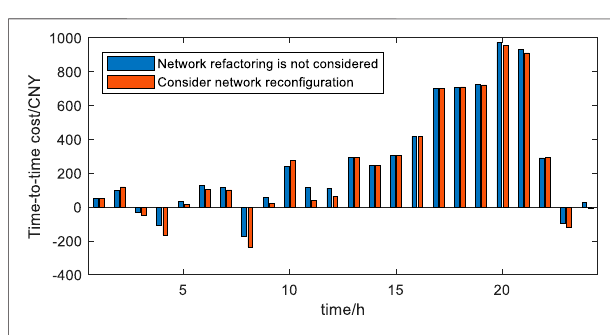
FIGURE 12 | Time-to-time operating cost comparison of the two